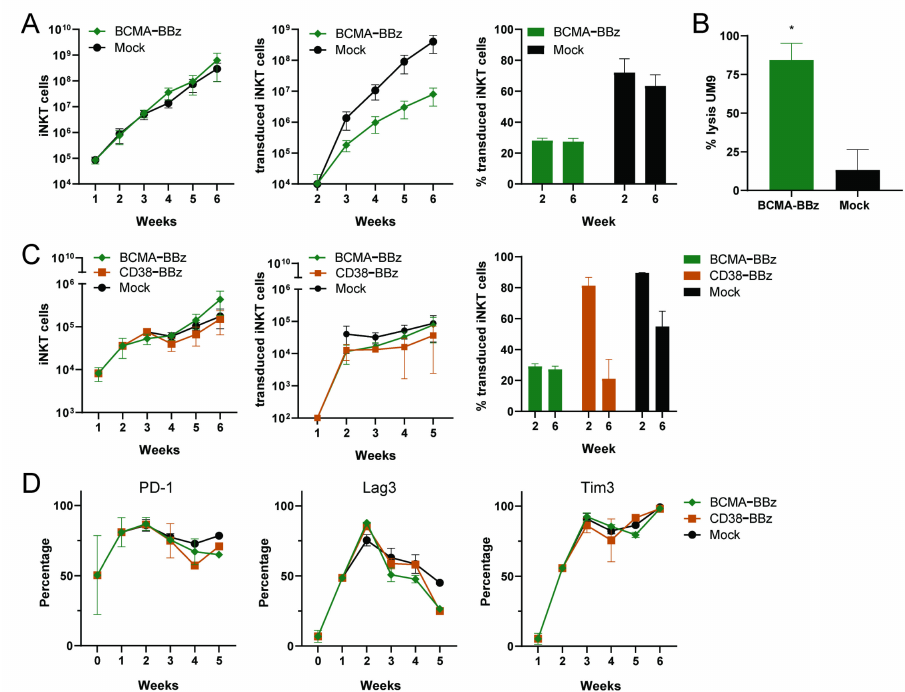
Figure 6. Expansion of functional CAR iNKT cells stimulated by α -GalCer loaded dendritic cells (DCs). BCMA-CAR iNKT cells and mock-transduced iNKT cells were weekly co-cultured with irradiated α -GalCer loaded DCs at an iNKT/DC ratio of 5:2, starting 4 days after transduction. ( A ) The calculated numbers of total iNKT cells (left), of transduced iNKT cells (middle), and the percentage of transduced iNKT cells at Week 2 and Week 6 of the culture (right). Error bars represent standard error of the mean (SEM) ( n = 4 donors). ( B ) The cytotoxic activity of BCMA-BBz CAR and mock-transduced iNKT cells against UM9 cells at an E/T ratio of 3:1. Error bars represent SEM ( n = 2) * p < 0.05 in a paired students T test. ( C ) Side by side comparison of CD38-BBz and BCMA-BBz iNKT cell expansion. Graphs show the calculated numbers of total iNKT cells (left), transduced iNKT cells (middle), and the percentage of transduced iNKT cells at Week 2 and 6 of cultures (right). Error bars represent SEM ( n = 2 donors). ( D ) The expression of exhaustion markers PD-1, Lag3, and Tim3 during culture ( n = 2).